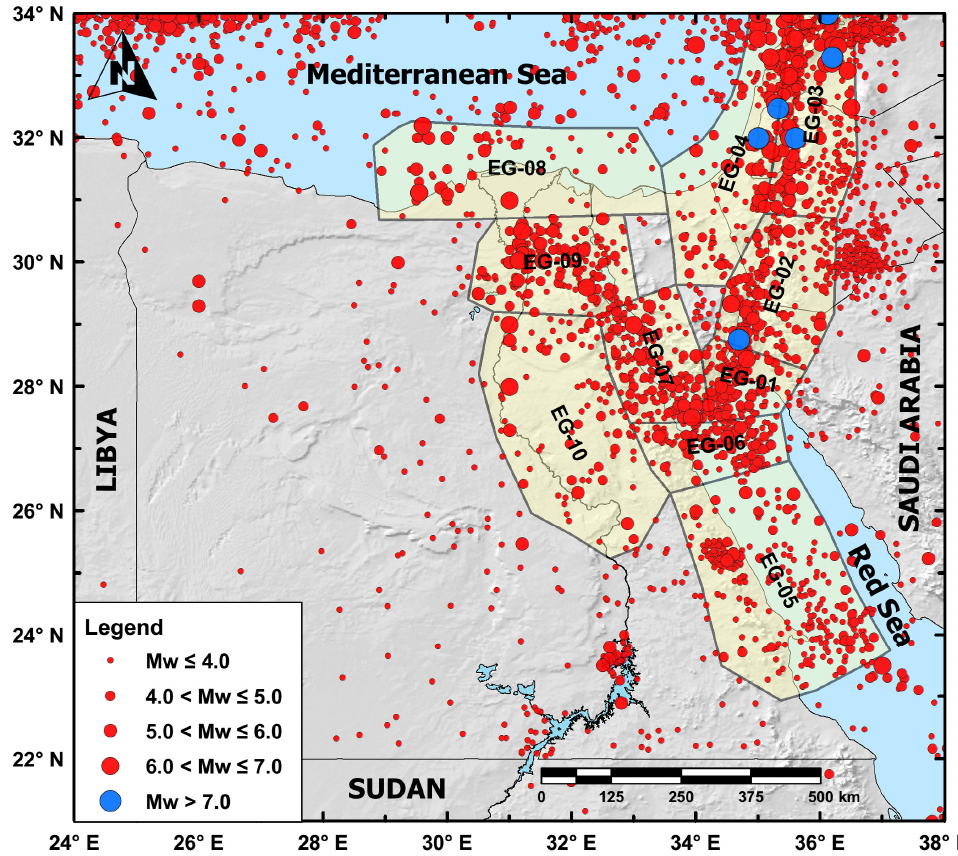
Figure 4. Spatial distribution of declustered instrumental seismicity (1900–2020).